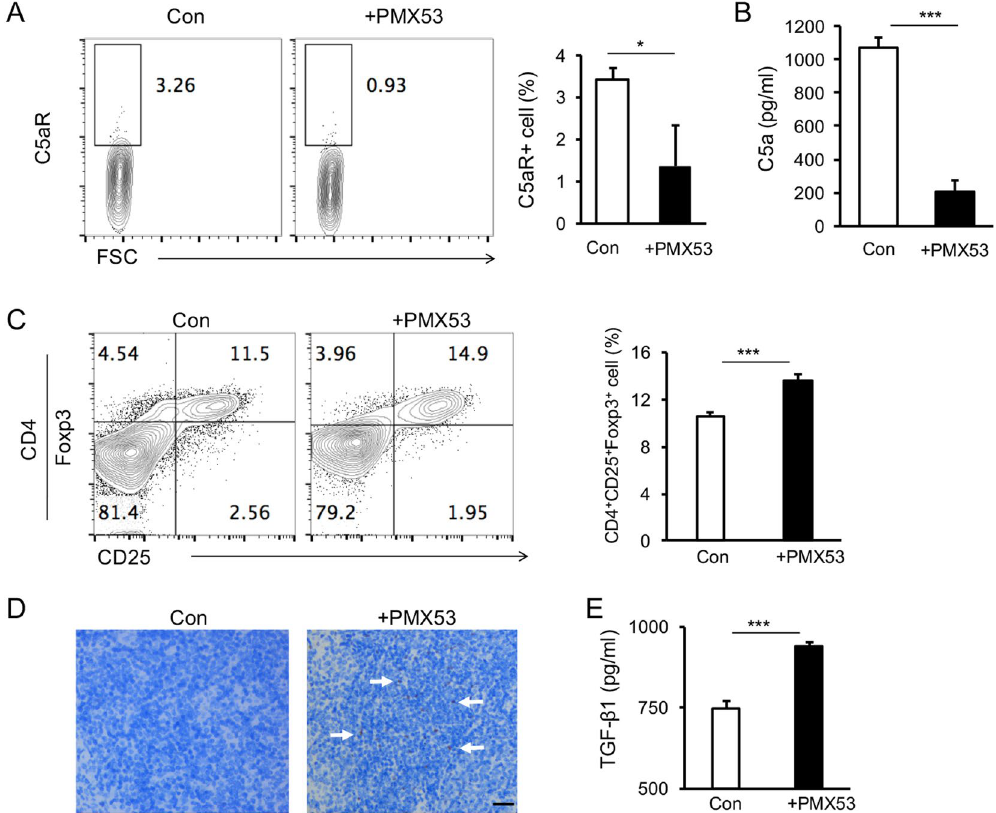
Figure 5. PMX53 treatment promoted the development of Treg and increased the accompanied expression of TGF- β 1. ( A ) Representative flow cytometry plots showed C5aR expression in monocytes from cGVHD mice with or without PMX53 treatment. ( B ) ELISA result revealed that PMX53 treatment reduced the level of C5a in plasma from cGVHD mice. ( C ) Representative flow cytometry plots showed CD25 and Foxp3 expression in CD4 + cells from cGVHD mice with or without PMX53 treatment. ( D ) Expression of Foxp3, a key transcription factor in Treg, was increased in histological sections of spleen from cGVHD mice after PMX53 treatment. ( E ) PMX53 treatment also promoted the expression of TGF- β 1 in the plasma in cGVHD mice compared with the control group. At least five mice were used in each group for flow cytometry and ELISA (N = 5) and three mice were used for histological analysis (N = 3), * p < 0.05, *** p < 0.001. Scale bar: 200 μ